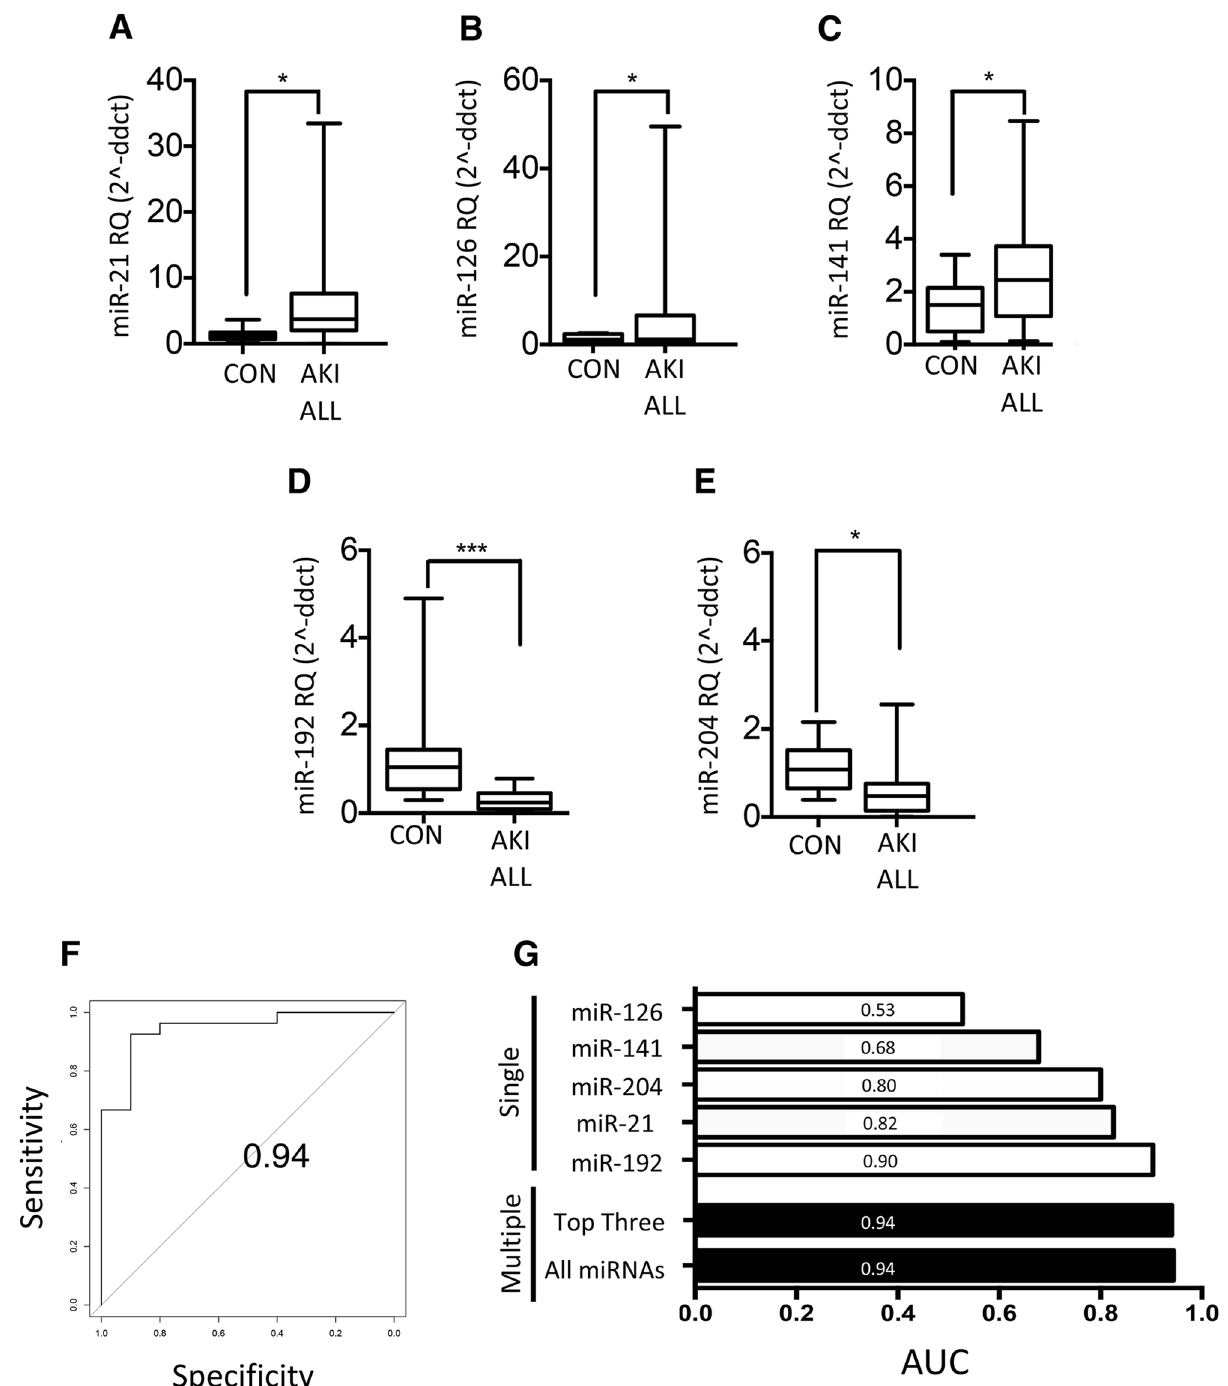
Figure 2. RT-qPCR detection of candidate miRNA biomarkers in AKI patient urine samples and control subjects. ( A - E ) Significant differences were observed between AKI patients (n = 29) and controls (n = 10) for (A) miR-21 (sevenfold increase), ( B ) miR-126 (fourfold increase), ( C ) miR-141 (twofold increase), ( D ) miR-192 (50% decrease) and ( E ) miR-204 (50% decrease). ( F ) Receiver operating characteristic (ROC) curve comparing all AKI patients with controls for all five miRNAs gave an area under the curve (AUC) = 0.94. ( G ) Bar graphs of AUCs for single and multiple miRNA comparisons between AKI patients compared to controls. Statistical analysis comparing two groups was carried out by Mann–Whitney U test. Data were normalised to endogenous control miR-191 and are presented as median ± range; *p < 0.05, ***p < 0.001. CON: control; AKI ALL: all AKI patients; Top Three: miR-192, miR-21 and